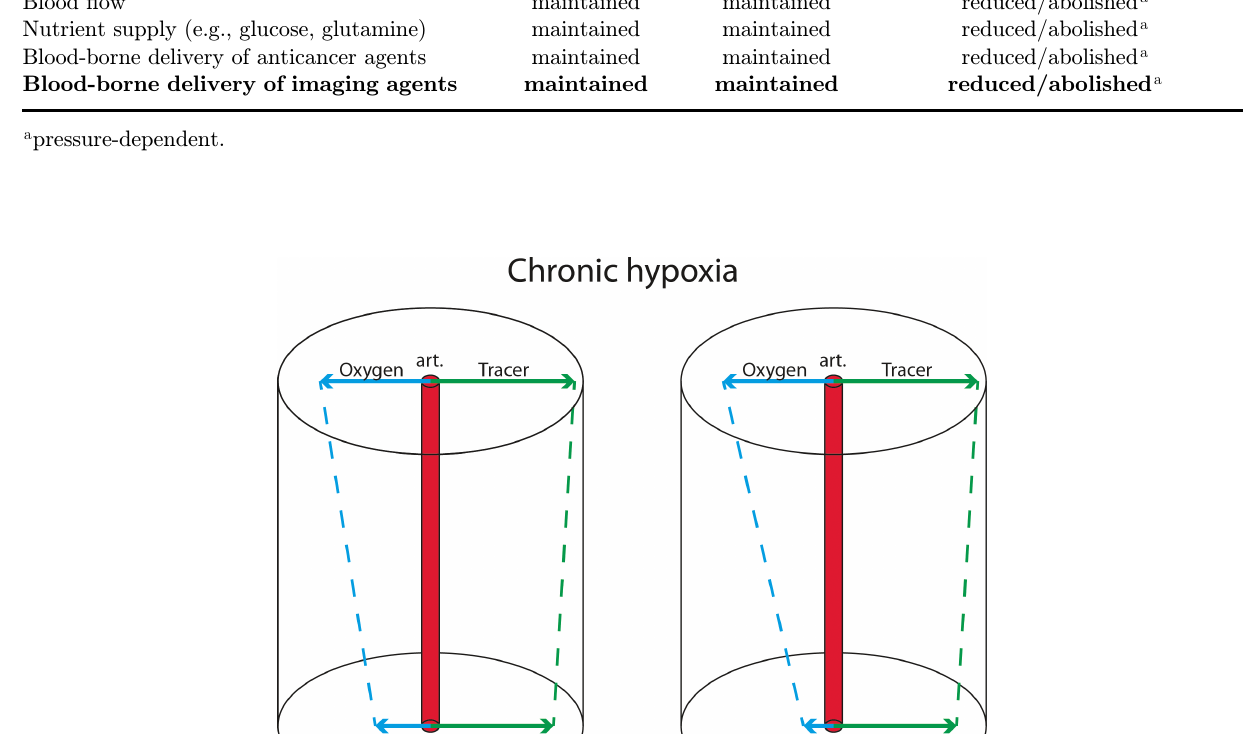
Table 2. Subtypes of chronic hypoxia according to causative mechanisms and associated blood-borne transport capacities. Causes